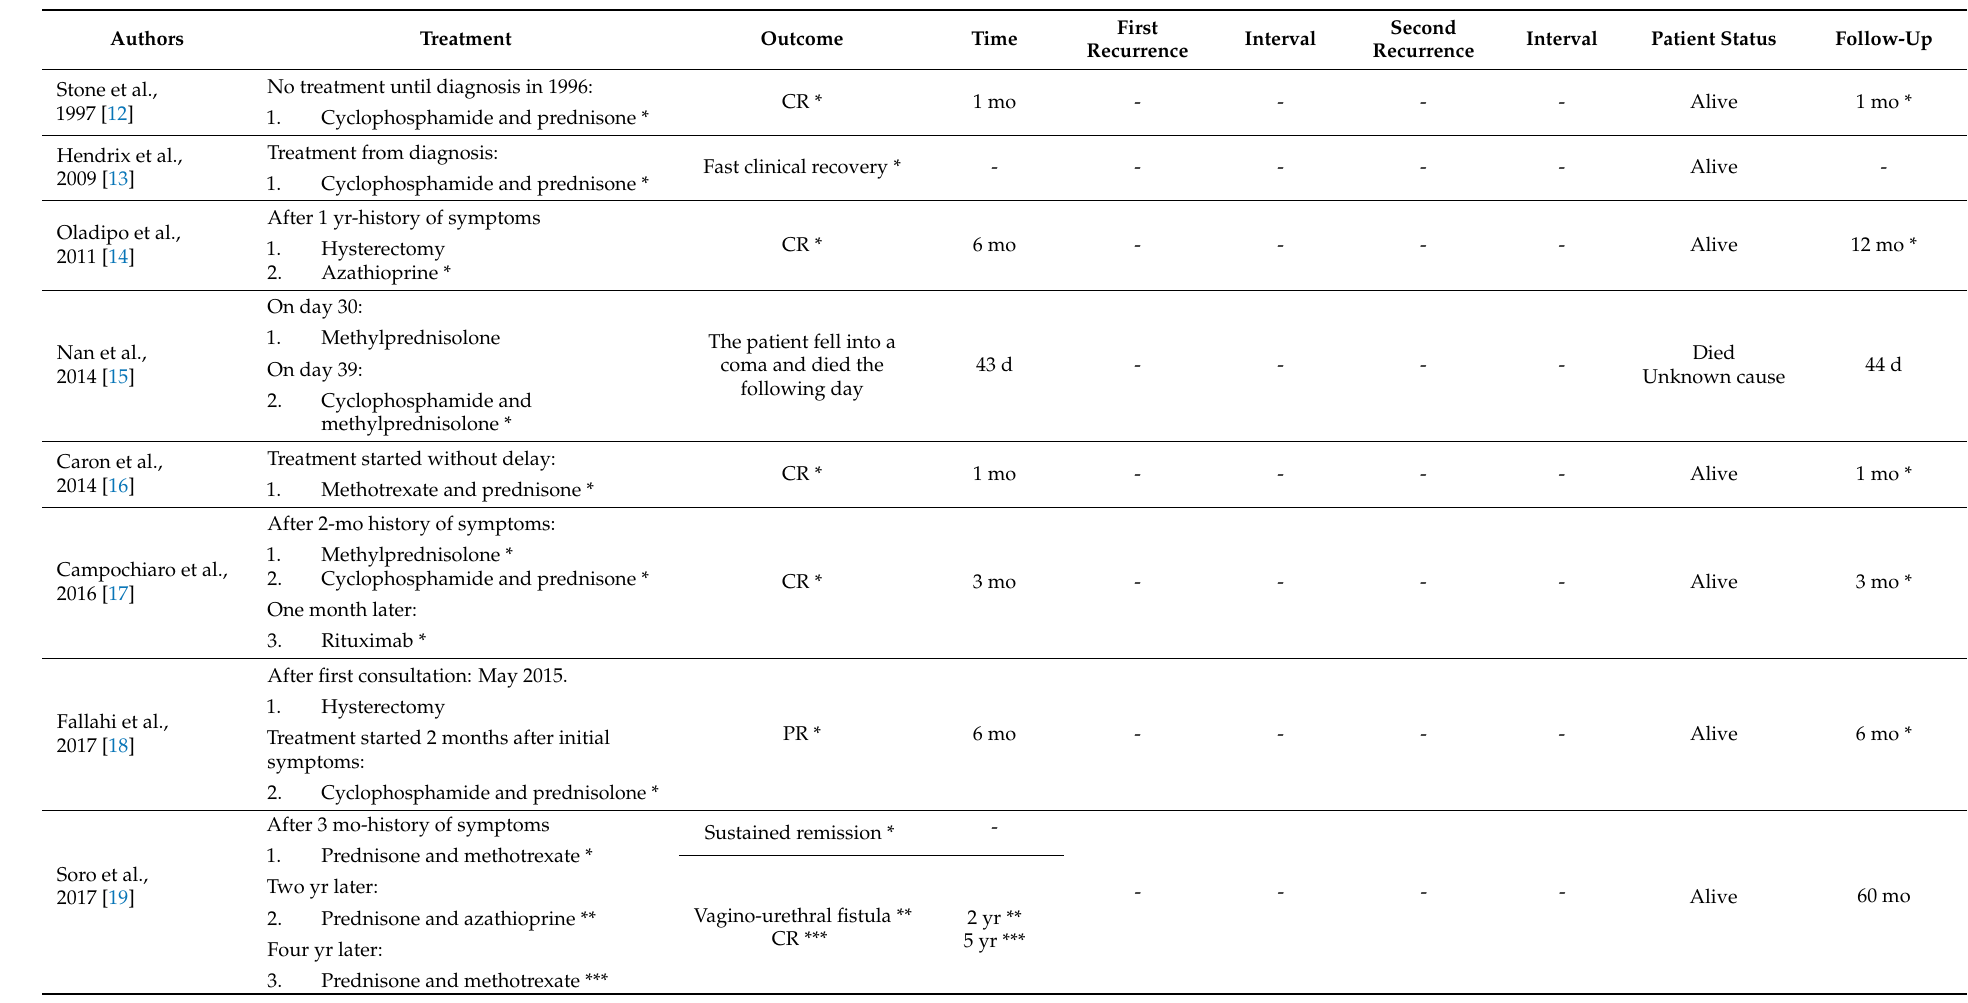
Table 3. Literature review of patients with GPA and primary gynecological